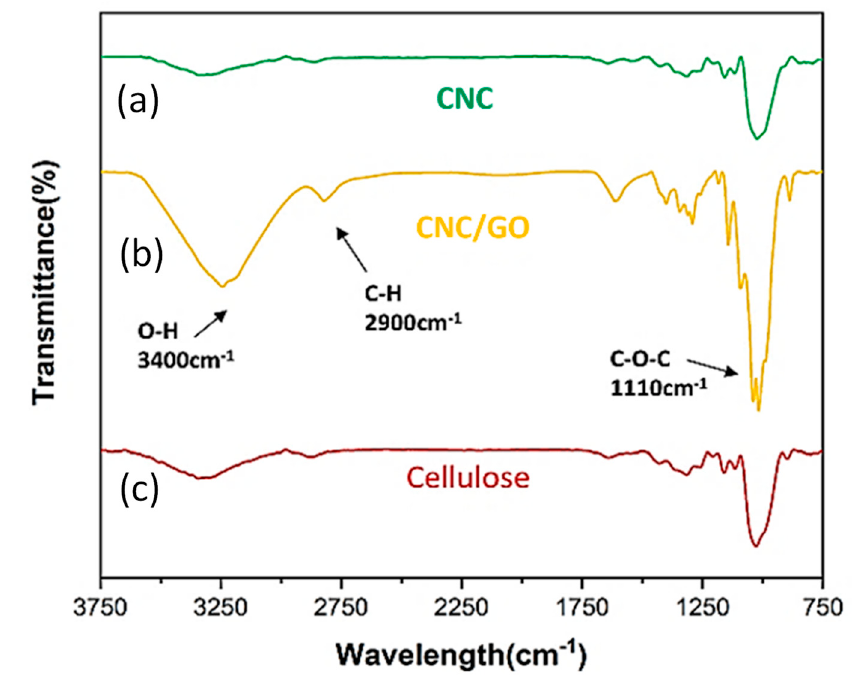
Figure 5. FTIR spectra of CNC, CNC/GO and pristine cellulose.